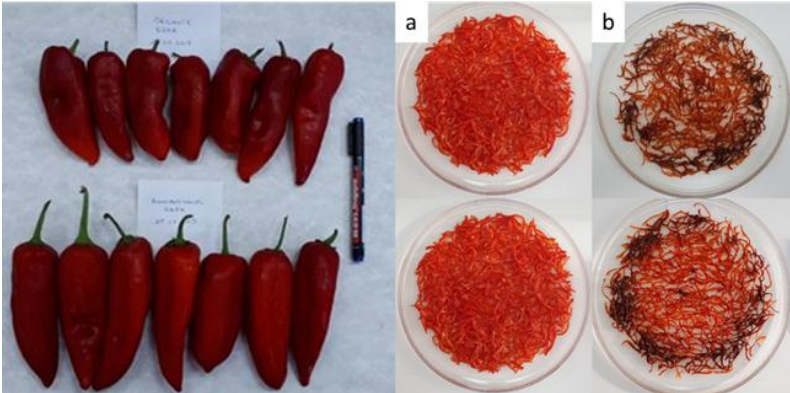
Figure 1. Whole organic ( above ) and conventional ( below ) sweet red peppers ( left ); ( a )—fresh organic ( above ) and conventional ( below ) pepper shreds; ( b )—dried organic ( above ) and conventional ( below ) pepper shreds.